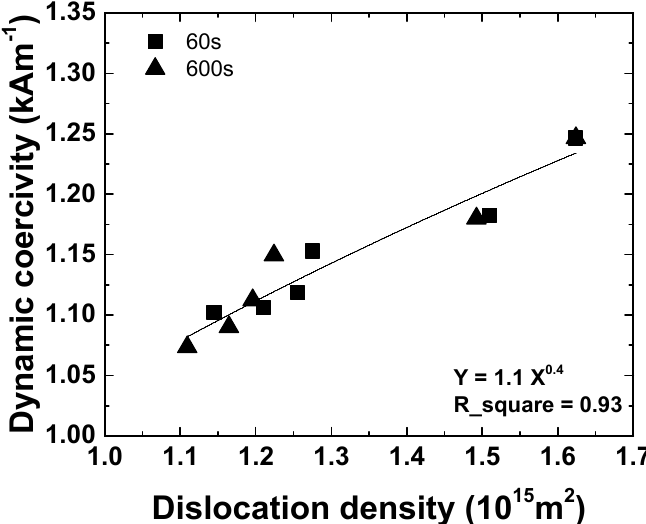
Figure 5. The interrelationship between dynamic coercivity and dislocation density is fitted to a nonlinear curve by the allometric model (y = ax b ).